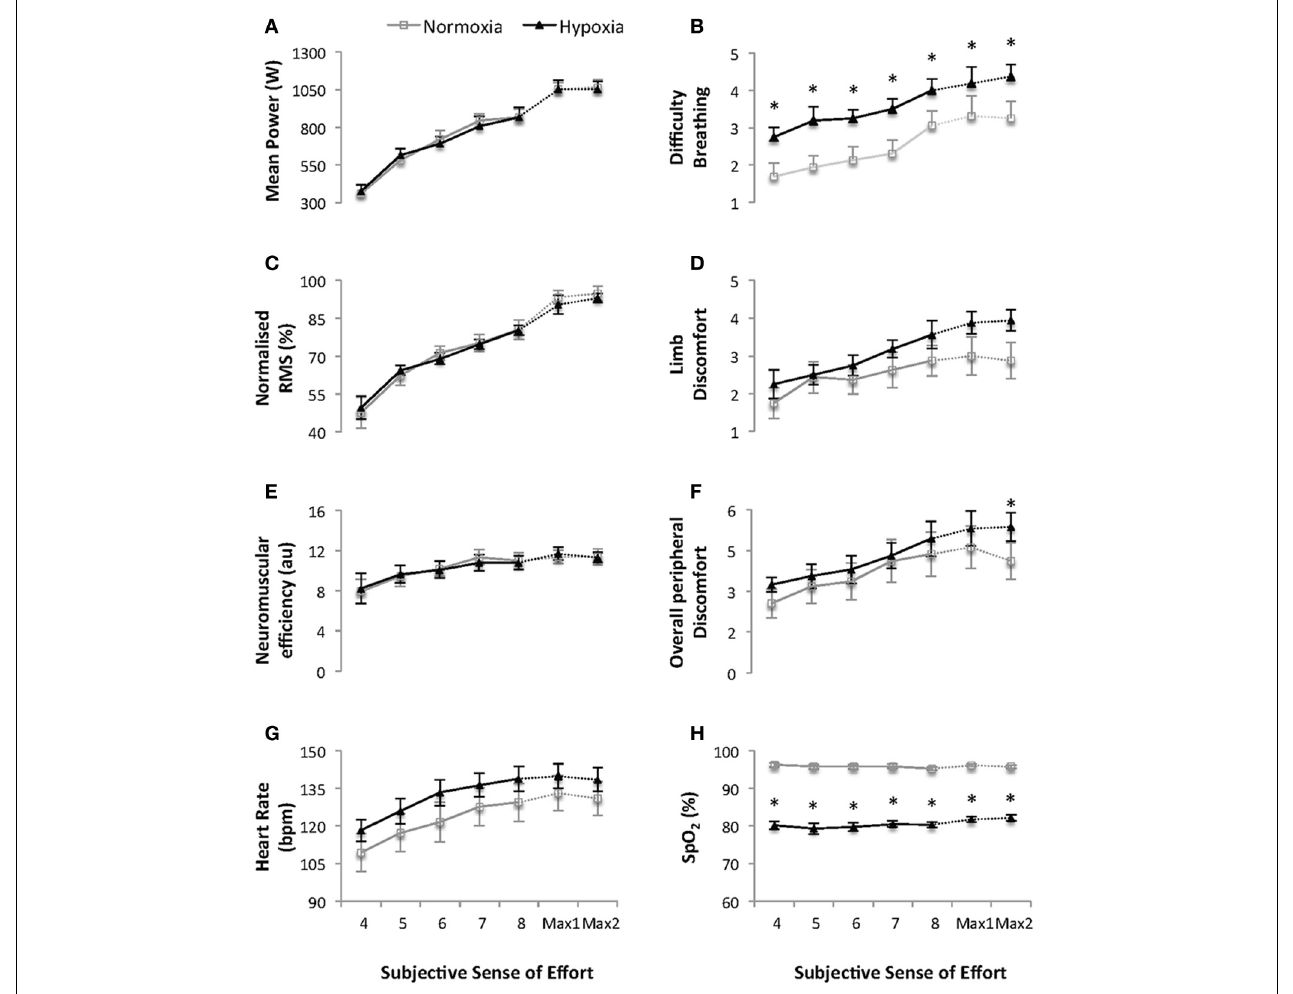
FIGURE 2 | Mean power output (W) (A), difficulty breathing (B), normalized quadriceps Root Mean Square (RMS) electromyographical activity (C), limb discomfort (D), neuromuscular efficiency (au) (E), overall peripheral discomfort (F), heart rate (bpm) (G) and arterial oxygen saturation (SpO 2 ) (H) for the five progressive and two maximal 4-s cycling bouts (sense